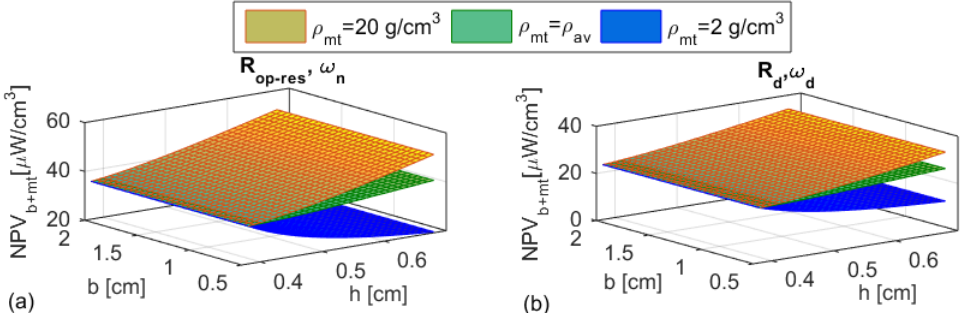
Figure 6. Normalized power to the volume of the beam and the tip mass (NPV b+mt ) at ( a ) the corresponding R op_res and ω n ( b ) the corresponding R d and ω d ( f n constant at 155 Hz, free length is 9.62 cm, mass ratio β varies from 0 to 0.52 for the corresponding total thickness varies from 0.382 to 0.682 cm, respectively, ζ m = 0.01, and u = 0.8 µ